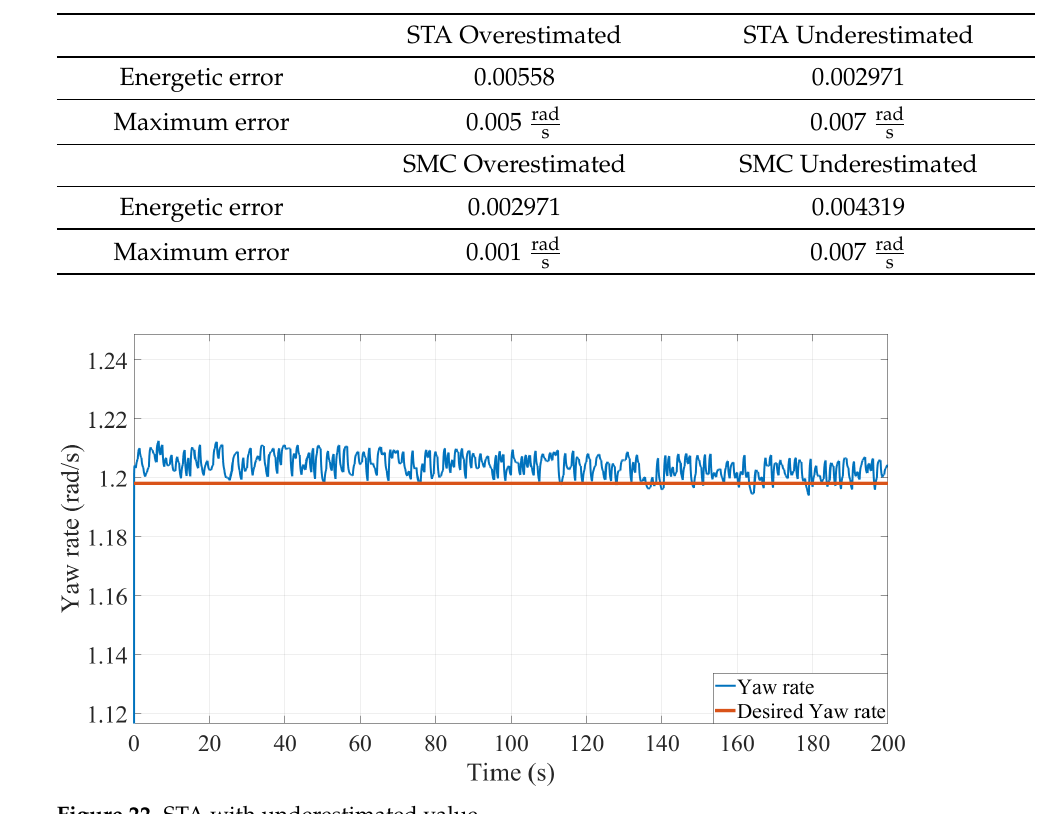
Table 6. Results.